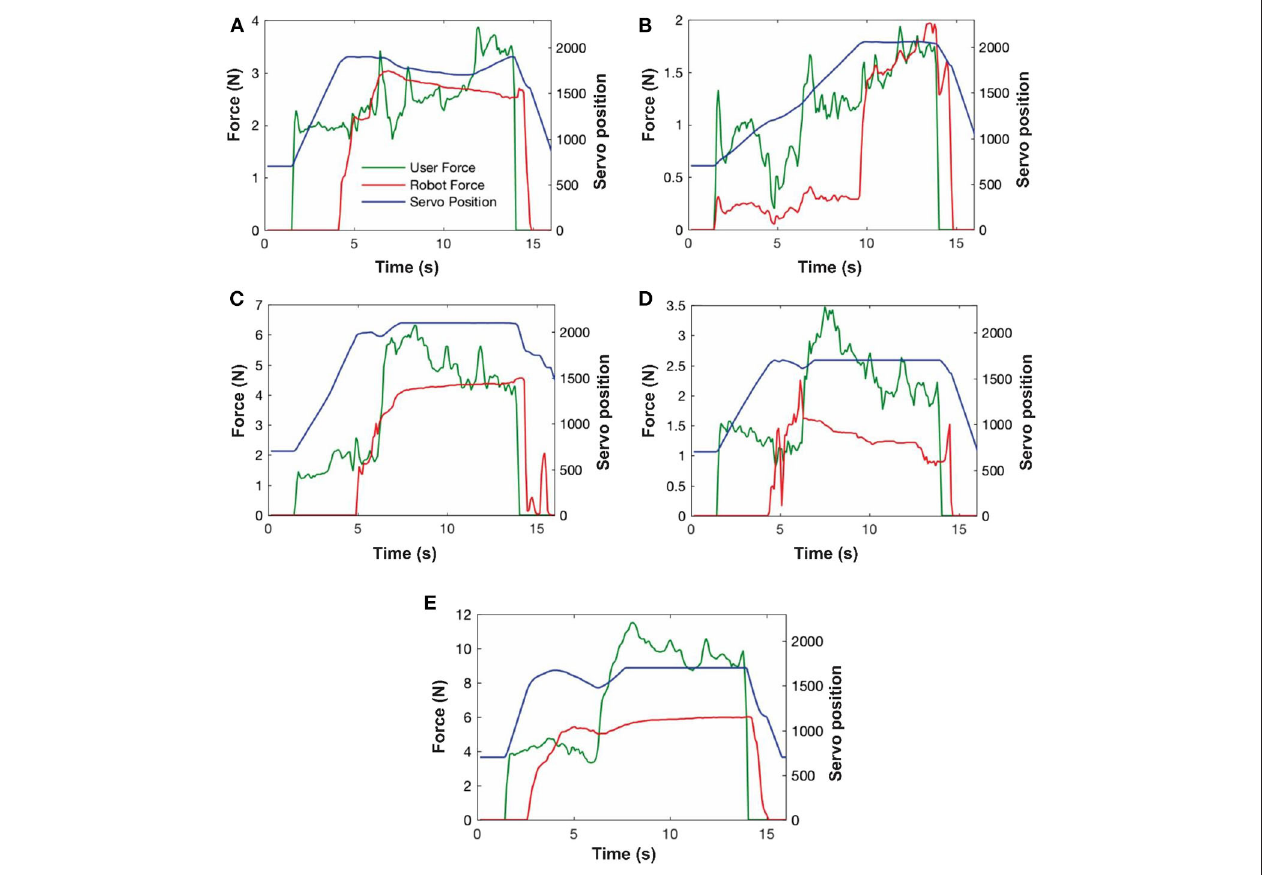
FIGURE 8 | Gripping screwdriver with force setpoint derived from user’s glove. (A) Index finger, (B) middle finger, (C) ring finger, (D) little finger, and (E) thumb.